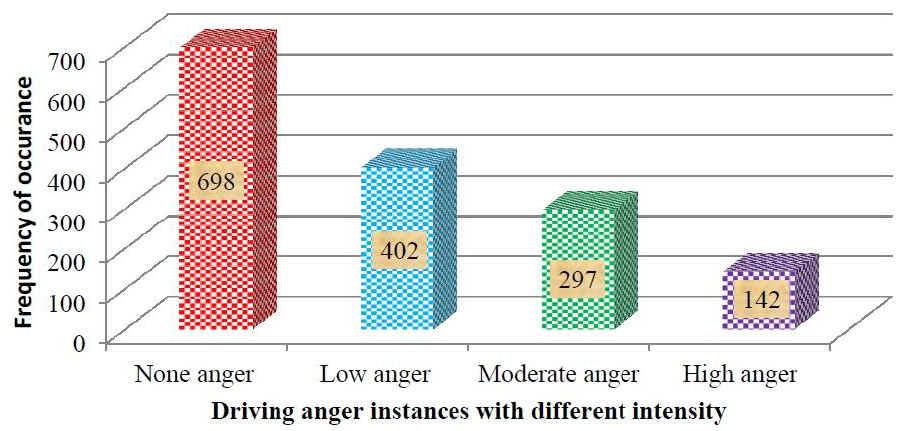
Figure 3. The number of different anger intensity instances.